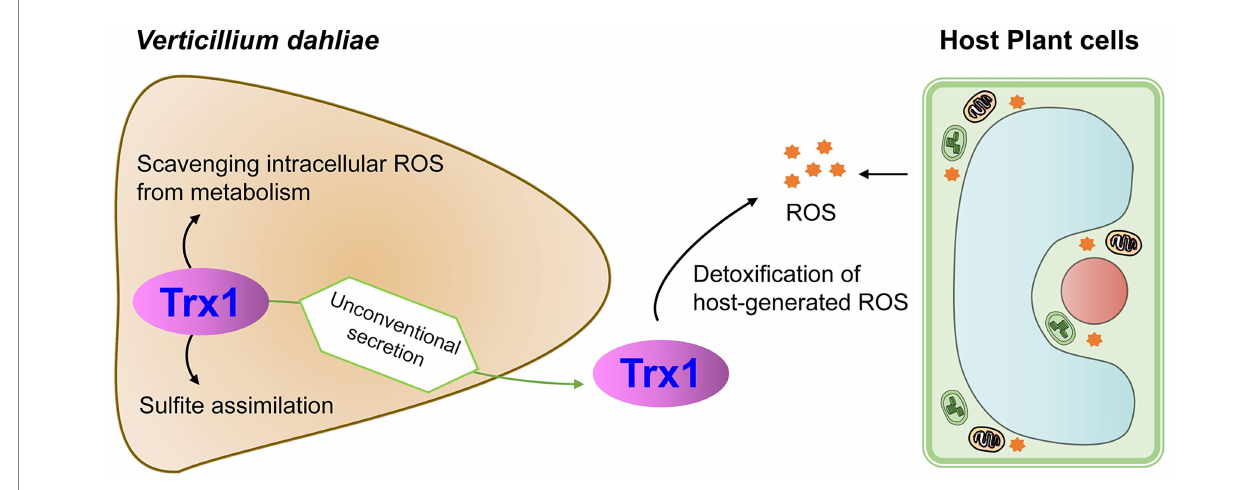
FIGURE 8 Proposed model of VdTrx1 function during V. dahliae -host